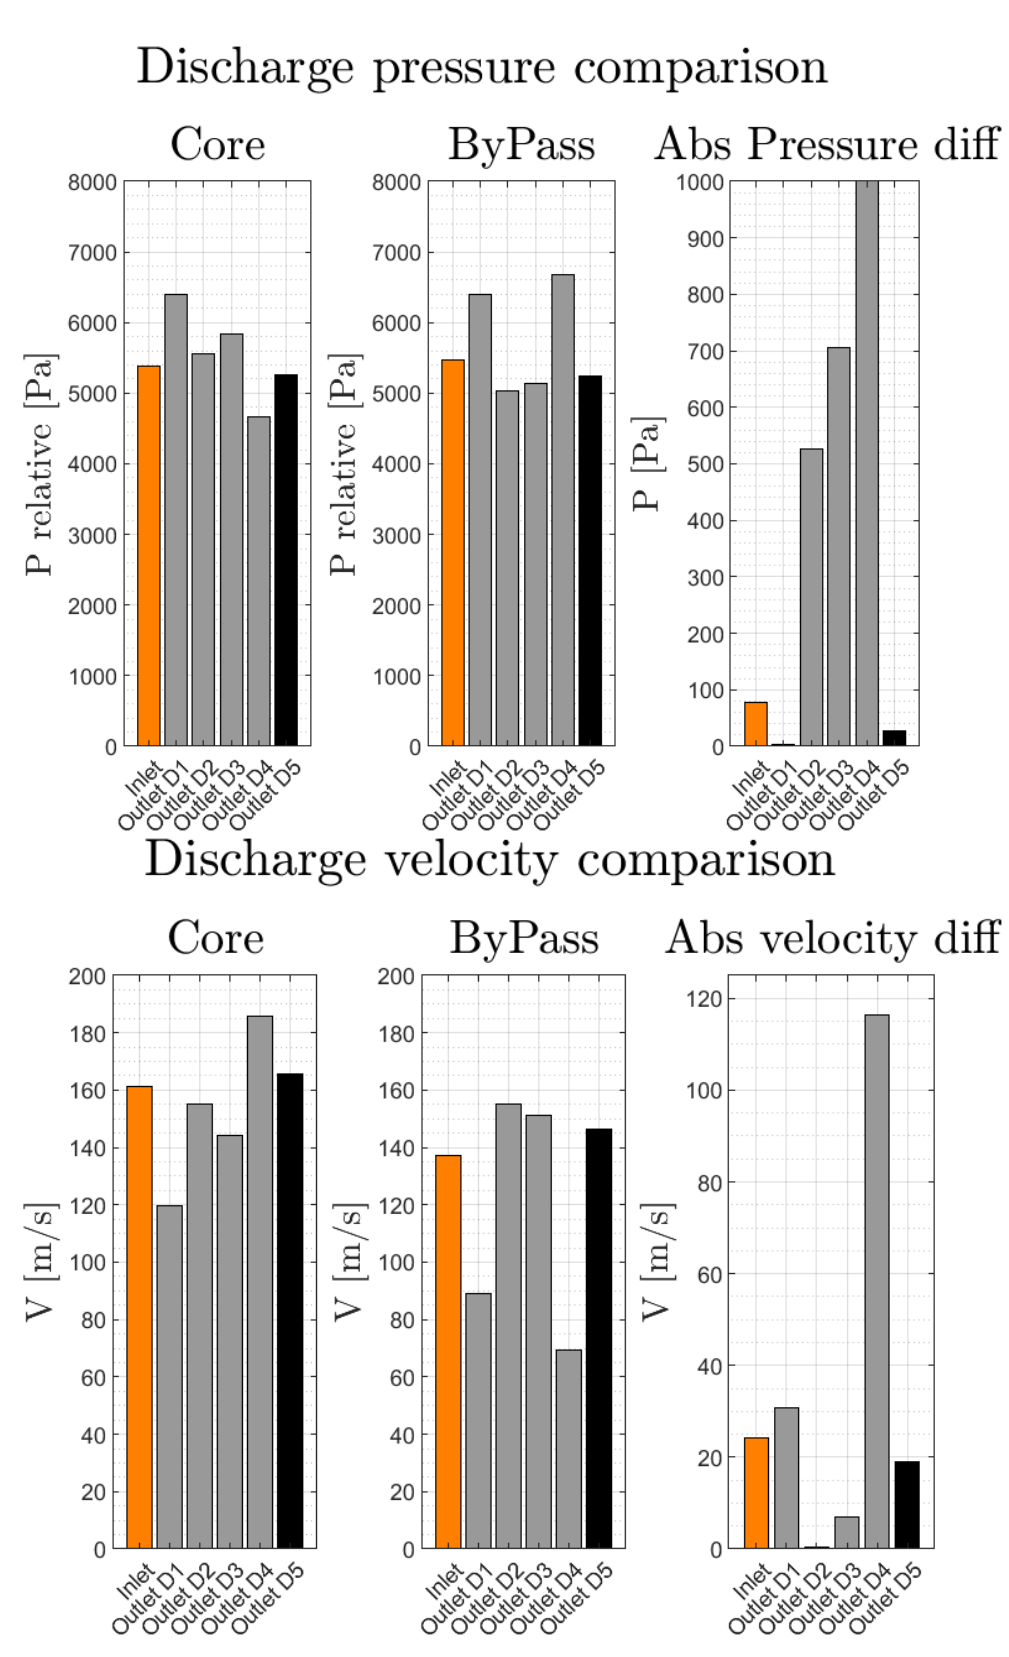
Figure 7. Evaluation of the different tested methods in terms of area, pressure and